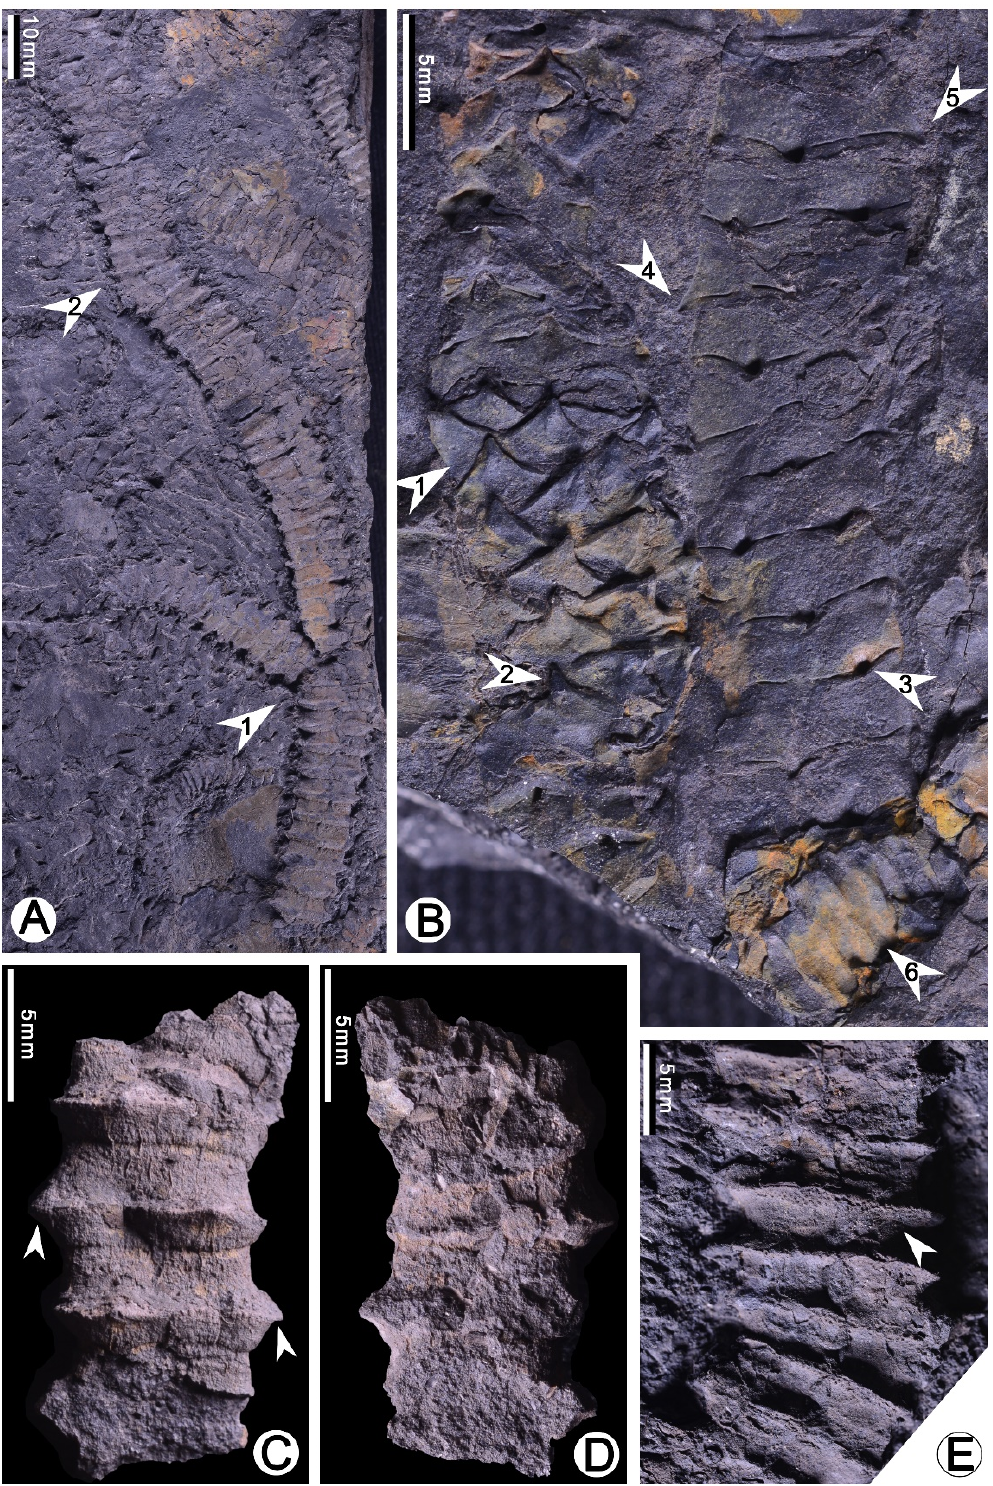
Figure 1. Barsassia ornata [17] from the Middle Devonian Hujiersite Formation, Hoxtolgay, West Junggar, Xinjiang, China. ( A ) A bifurcated leafy stem with obvious step-like structure on the surface. PB23702. ( B ) Neotype. Two stems with imbricately and tightly arranged leaves, leaf shape in a variety ranging from fan-shaped (arrow 1), fan-shaped with short awl-shaped tips (arrow 2), and rectangular-shaped (arrow 3) in surface view. Arrow 6 indicates the step-like stem. PB23703. ( C , D ) A three-dimensional cast of the stem with tipped leaves (arrows), one and its reverse side PB23704. ( E ) Enlargement of a portion of leafy stem indicated by arrow 2 in A, showing the step-like structure of the stem and dots on leaf surface